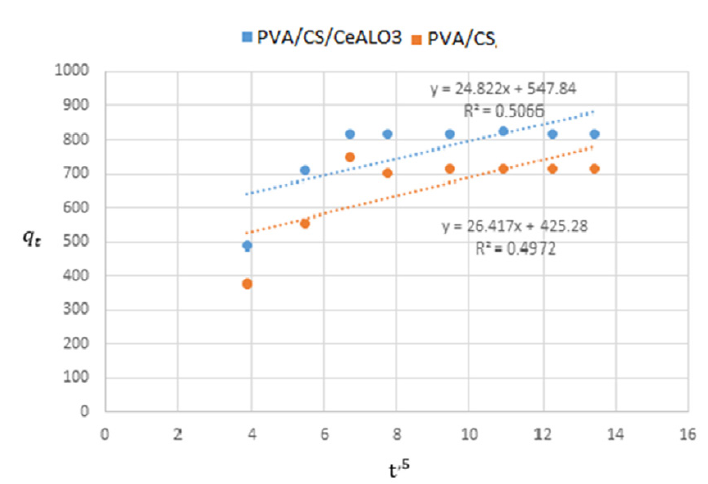
Fig. 12. intraparticle diffusion plot sorption of MB onto PVA/CS and PVA/CS/ CeAlO